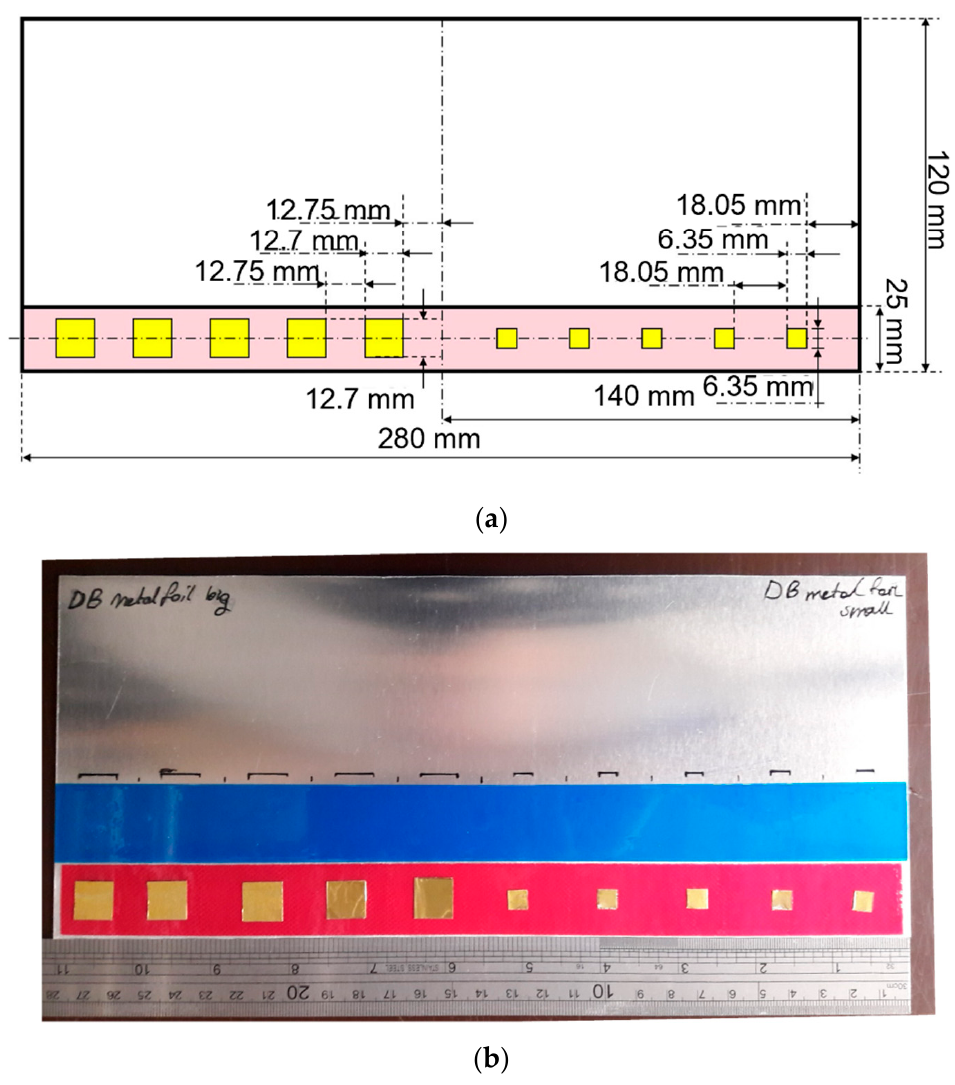
Figure 2. Single lap adhesive joints with brass inclusions prior to bonding: ( a ) schematic; ( b ) aluminum–epoxy joint.